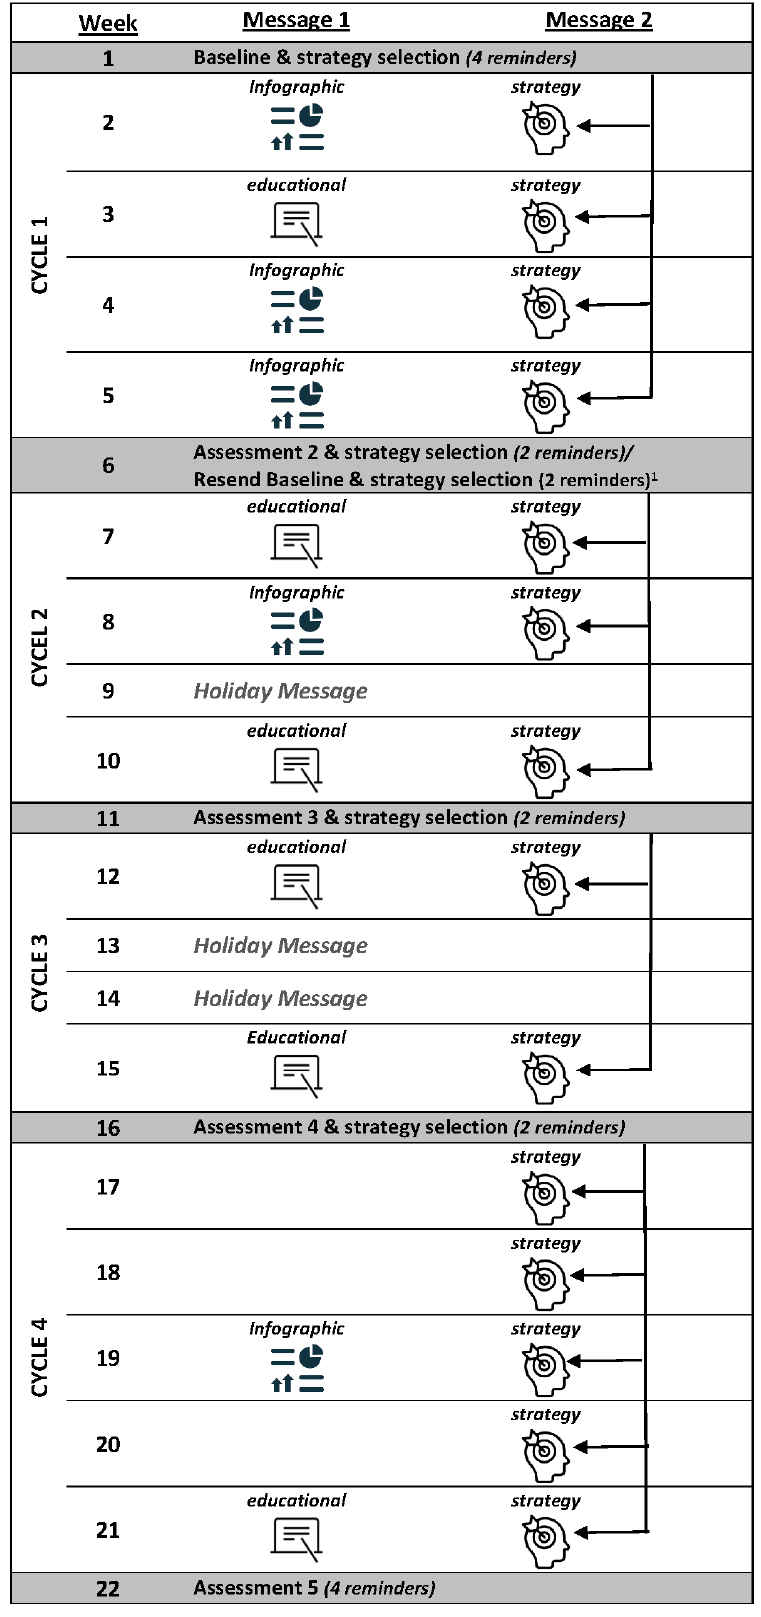
Figure 2. Sample caregiver SMS intervention implementation process. 1 Baseline Assessment is resent at the time of Assessment 2 for those who did not respond to the original Baseline Assessment. Intake responses for these caregivers serve for both Baseline and Assessment 2.